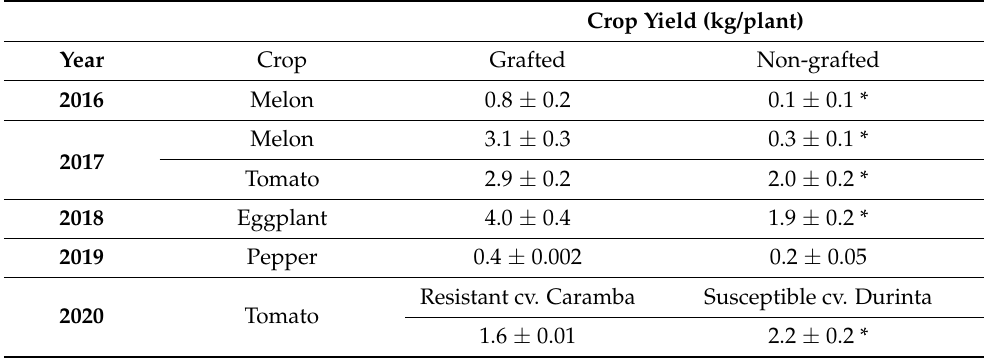
Table 5. Variation of crop yield between grafted and non-grafted plants for the different species cultivated during the different years, *: ANOVA test significance p ≤ 0.05. Crop Yield